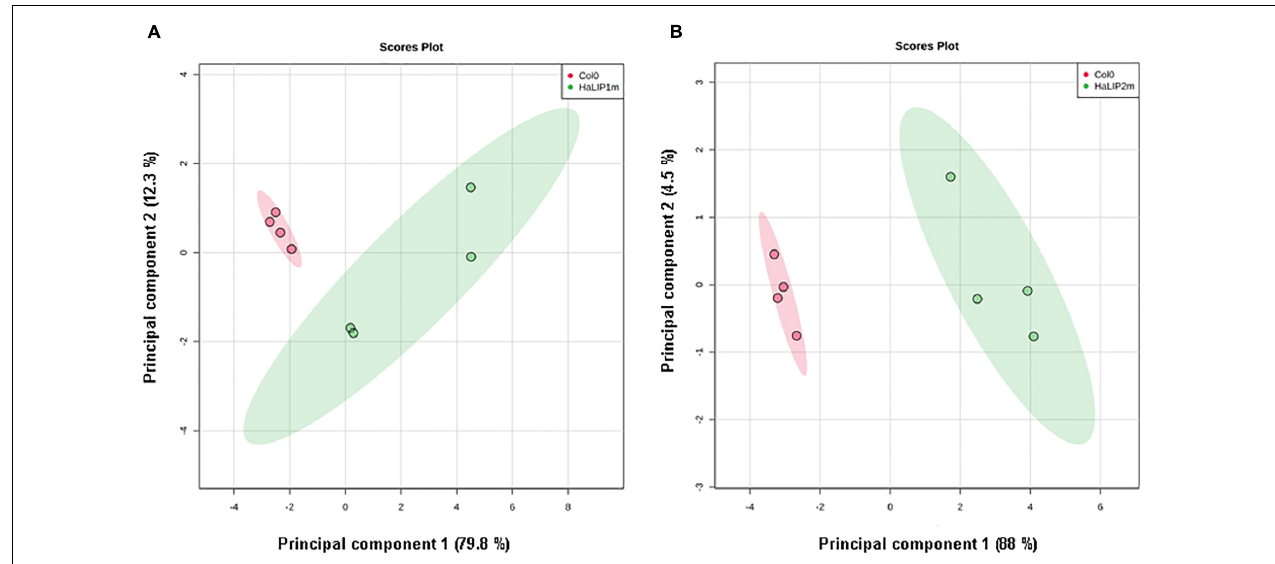
FIGURE 9 | Principal component analysis (PCA) showing similar relationships between mature Arabidopsis WT Col-0 seeds and transgenic HaLIP1m (A) and HaLIP2m (B) seeds. The two principal components explain 92.1% ( HaLIP1m ) and 95.5% ( HaLIP2m ) of the variance. Controls, red circles and transgenic seeds, green circles.